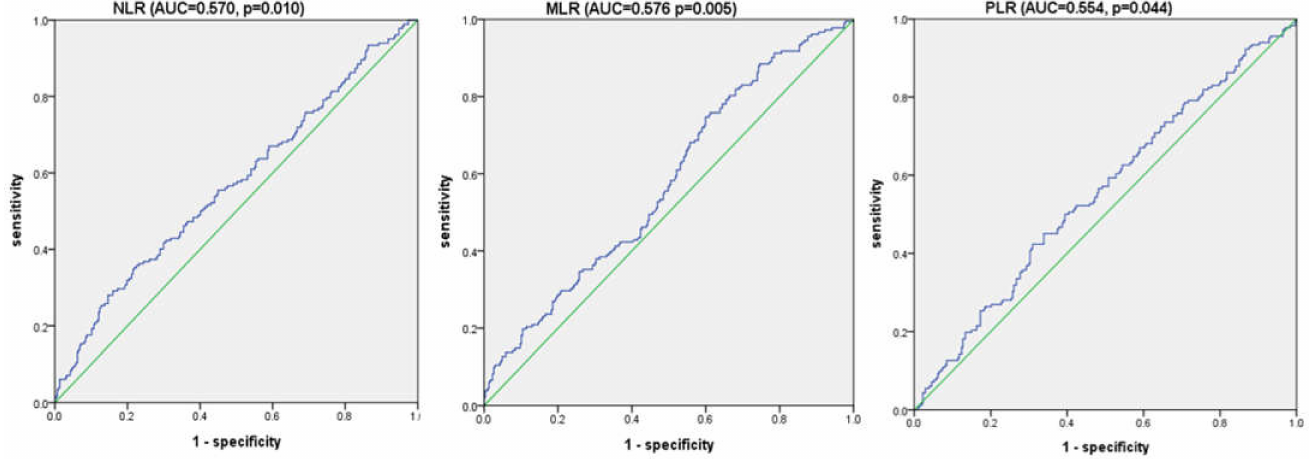
Figure 1. Receiver operating characteristic (ROC) curve analysis for overall survival